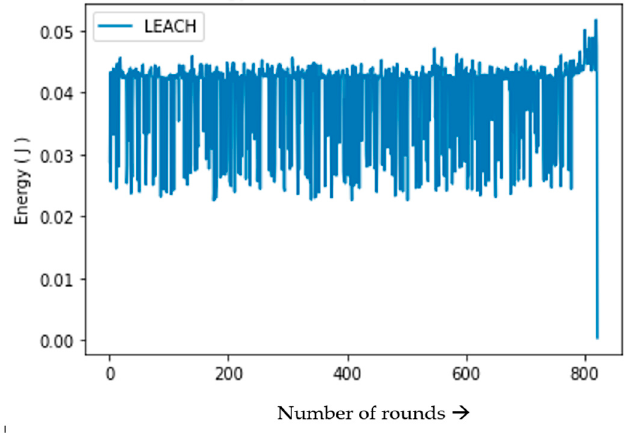
Figure 10. Energy dissipation per round in LEACH.